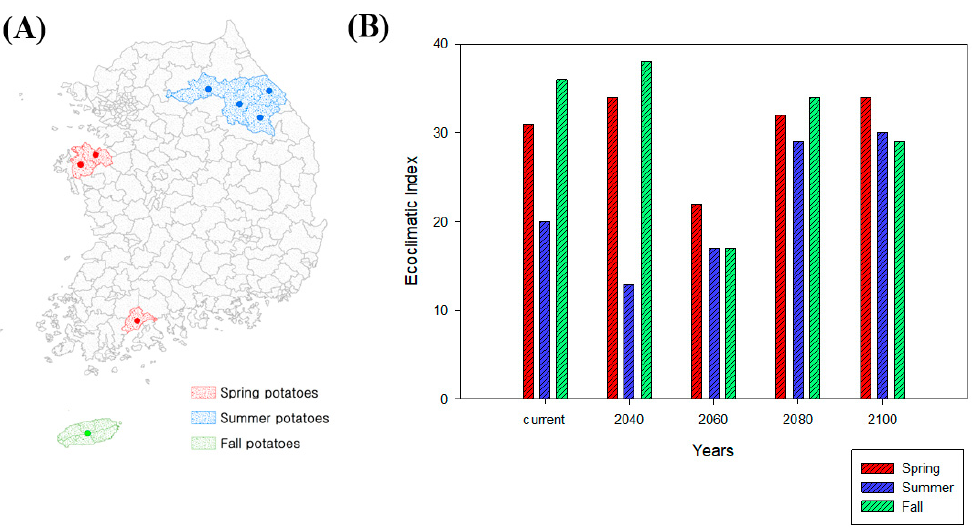
Figure 5. Major areas cultivating seasonal potatoes in South Korea ( A ) and changes in the ecoclimatic index for major cultivation areas in response to climate change ( B ). Same colors were used for cities in ( A ) and ( B